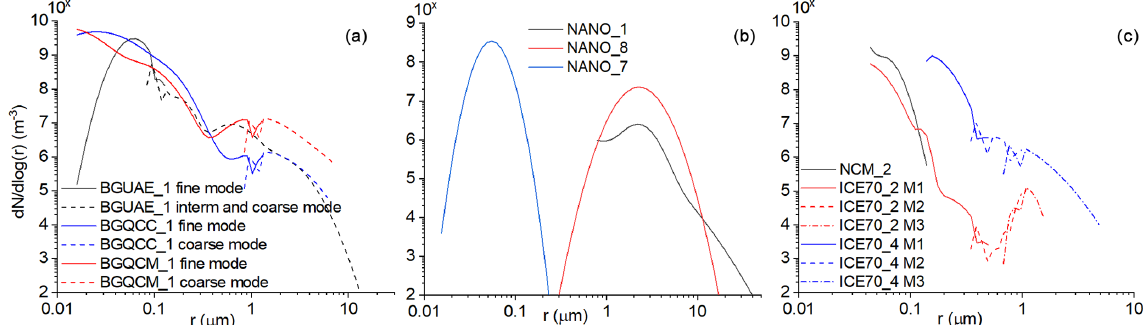
Figure 2. Initial size distributions of (a) the background aerosols, (b) seeding nanoparticles and (c) seeding flares. The parameters of the size distributions are given in Tables 1 to